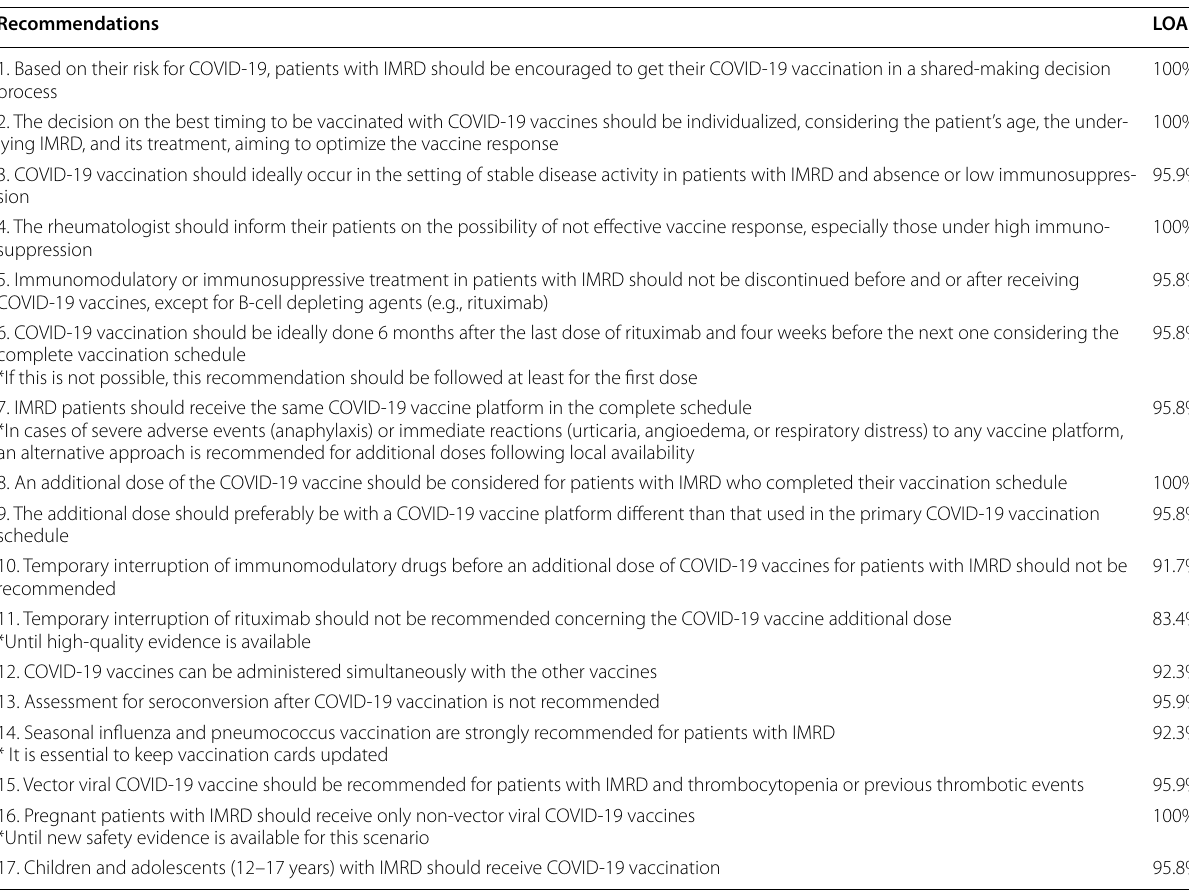
IMRD: immune-mediated rheumatic diseases